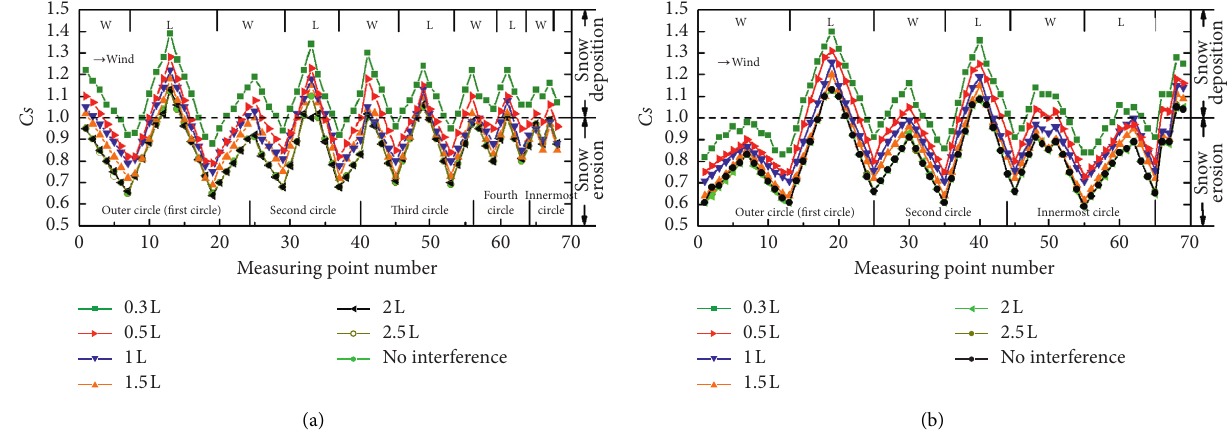
Figure 13: Snow distribution on the gymnasium and stadium surfaces for different spacings between structures. (a) Gymnasium. (b) Stadium.